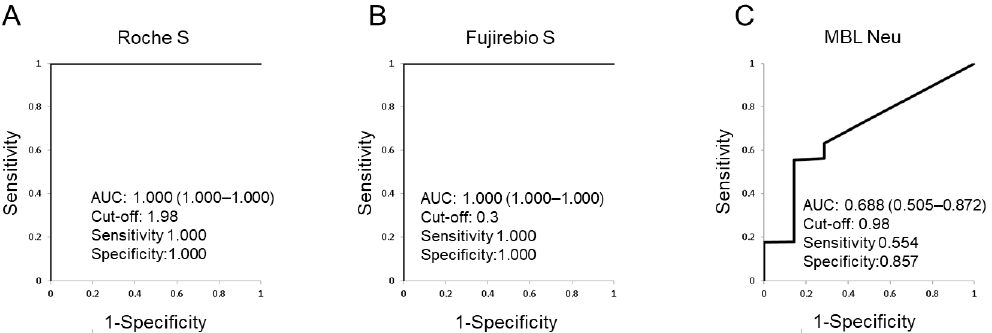
Figure 1. Receiver operating characteristic (ROC) curve analyses of SARS-CoV-2 Abs. ROC curves for Roche S ( A ), Fujirebio S ( B ), and MBL Neu ( C ). The area under the curve (AUC) values of the ROC curves with 95% confidence intervals and the optimized cut-off levels with specificities and sensitivities are depicted. ROC: receiver operating characteristic, AUC: area under the curve. SARS- CoV-2: severe acute respiratory syndrome coronavirus 2, Roche S: Roche Elecsys anti-SARS-CoV-2 S, Fujirebio S: Fujirebio SARS-CoV-2 S IgG, MBL Neu: MBL Anti-SARS-CoV-2 neutralization Ab.